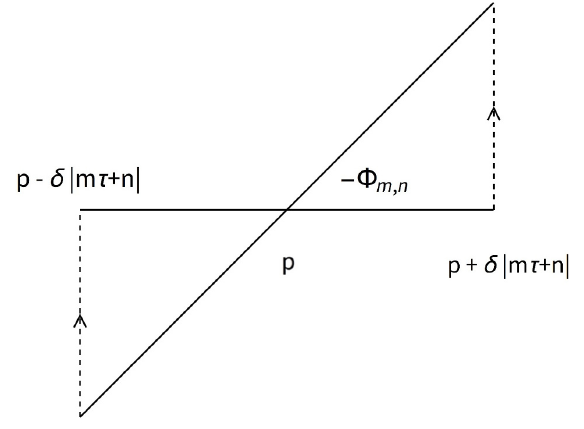
Figure 6 . The integral along the diagonal bit matches the one along the horizontal bit. Before assuming the Cardy-like expansion, we can slightly deform the real contour (avoiding crossing poles) so that in a complex vicinity of the bit, the deformed contour matches the diagonal piece in the figure and not the horizontal one. Then to compute contributions of bits, one can do the integral along the diagonal contour instead of the horizontal one. To further justify the previous argument, one would need to prove that contributions from dashed contours cancel in Cardy-like limit: this will be proven in the appendix